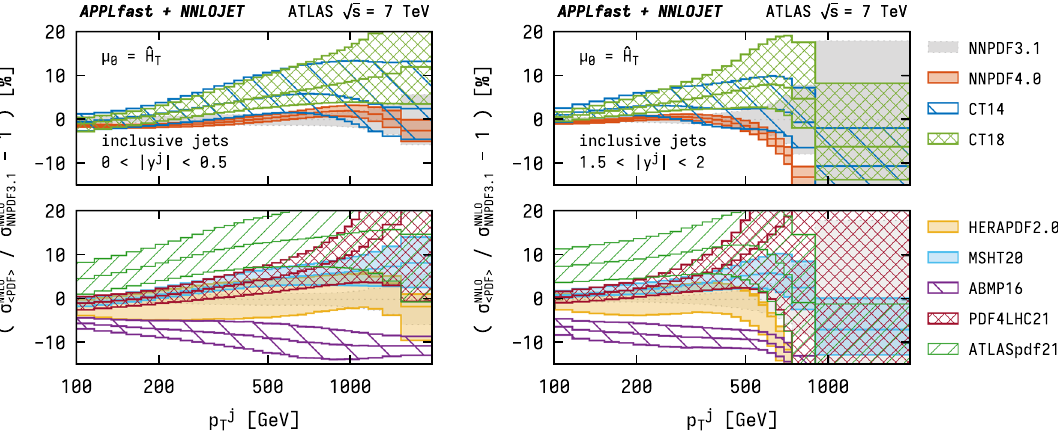
Fig. 4 NNLO predictions for the ATLAS 7TeV inclusive jet cross section as a function of p jet various different PDF sets. The shaded areas indicate the respective PDF